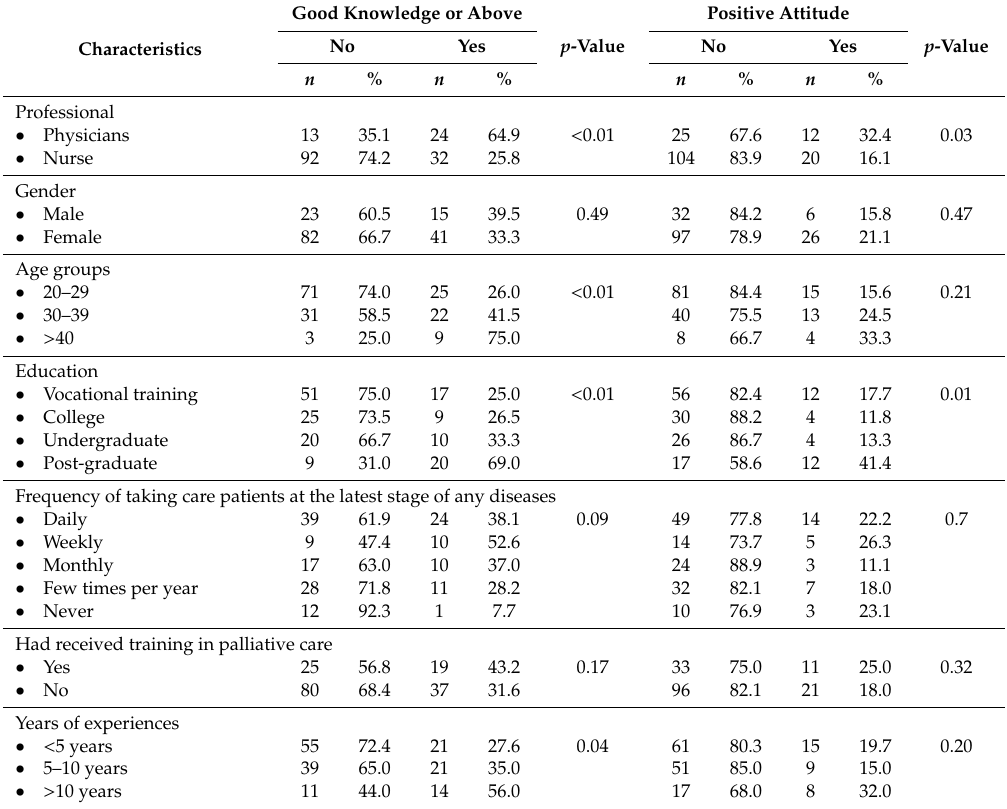
Table 3. Knowledge and attitude toward palliative care according to di ff erent